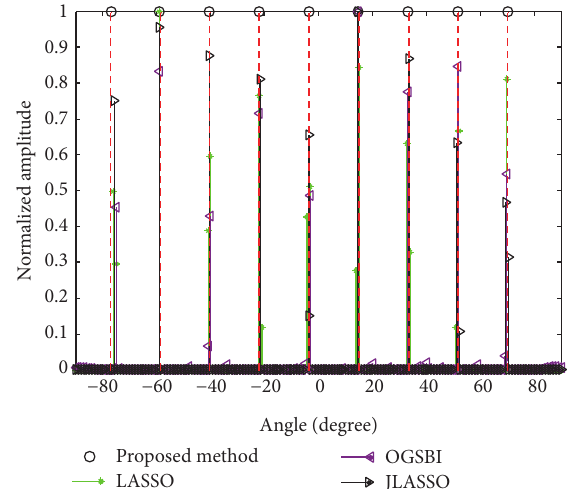
Figure 6: Spatial spectrums of LASSO, OGSBI, and the DOA results of the proposed method (𝐾 = 9, 𝜆 𝑡 = 0.25)